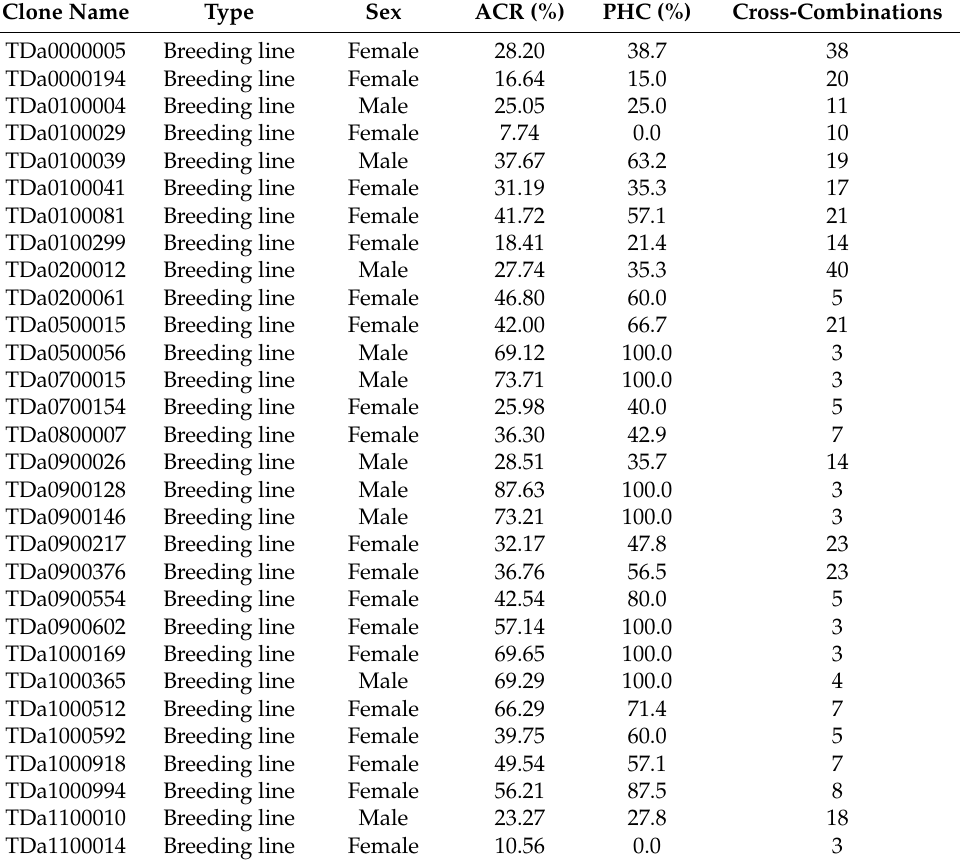
Table 1. Type, sex and cross-compatibility indices (ACR and PHC) of D. alata clones used for GWAS analyses. Presented information is the summary of 2010–2020 historical data at IITA breeding sites,